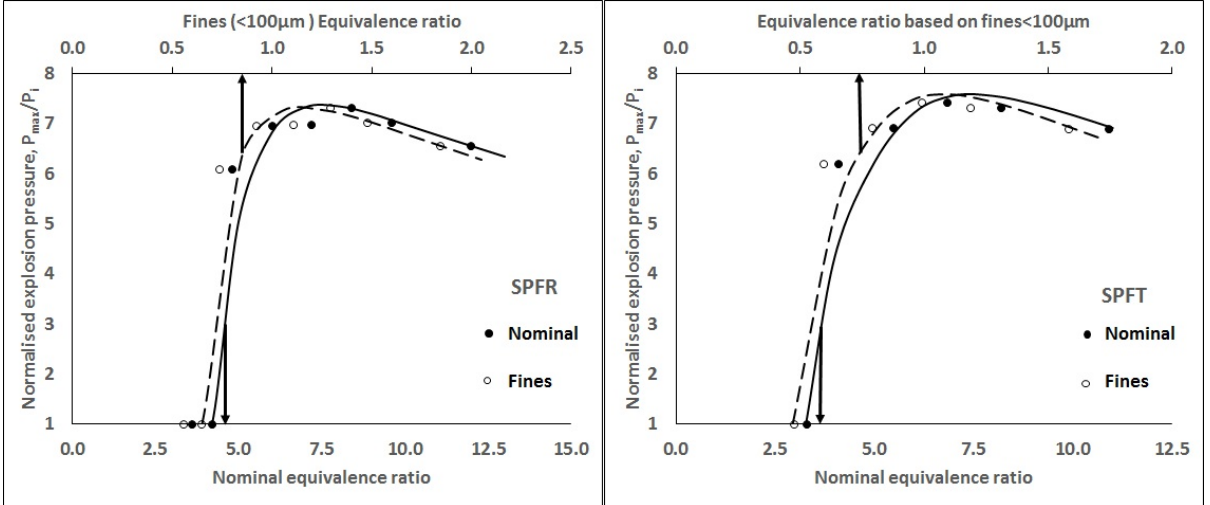
Figure 5. Normalized maximum explosion pressure (Pmax/Pi) vs. Equivalence ratio (Ø) for raw SPF and torrefied SPF wood mixture.